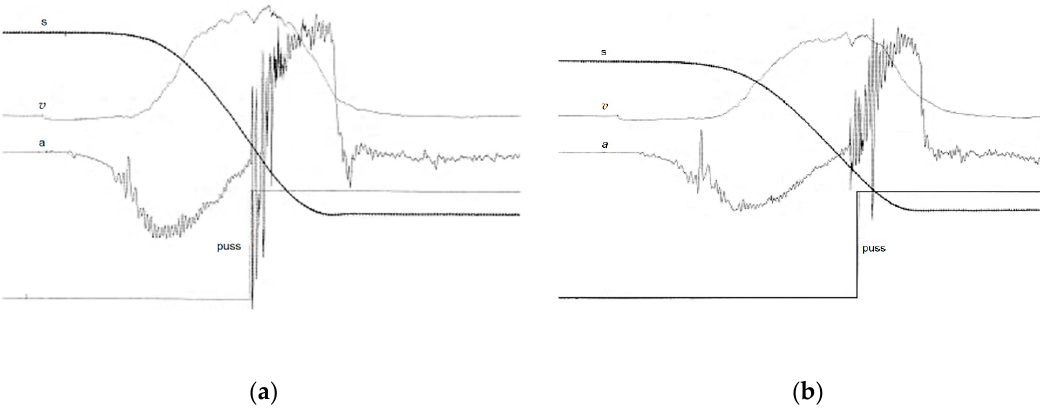
Figure 33. Exemplary laboratory results of the tested tulip contact system: v —speed, a —acceleration, s —path, and puss—characteristic that indicated contact between system elements. ( a ) With bounce and ( b ) without bounce.